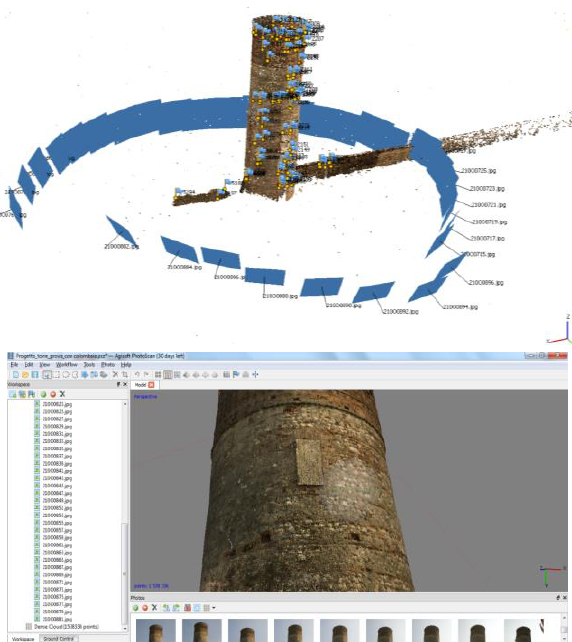
Figure 4. The position of image acquisition planning and estimated camera 3D position after orientation